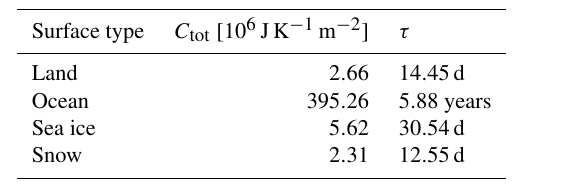
Table 2. Total heat capacities C tot = C atmos + C i and resulting re- laxation times τ for surface type i .